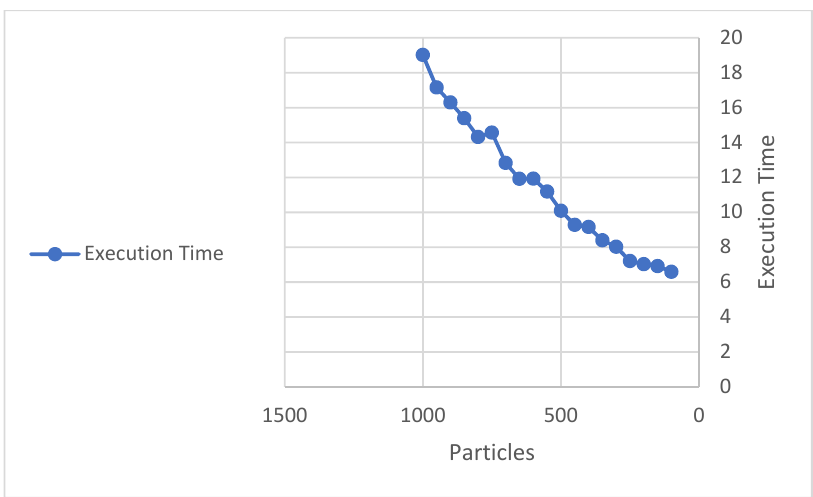
Figure A3. The relation between processors and speedup in parallel processing.